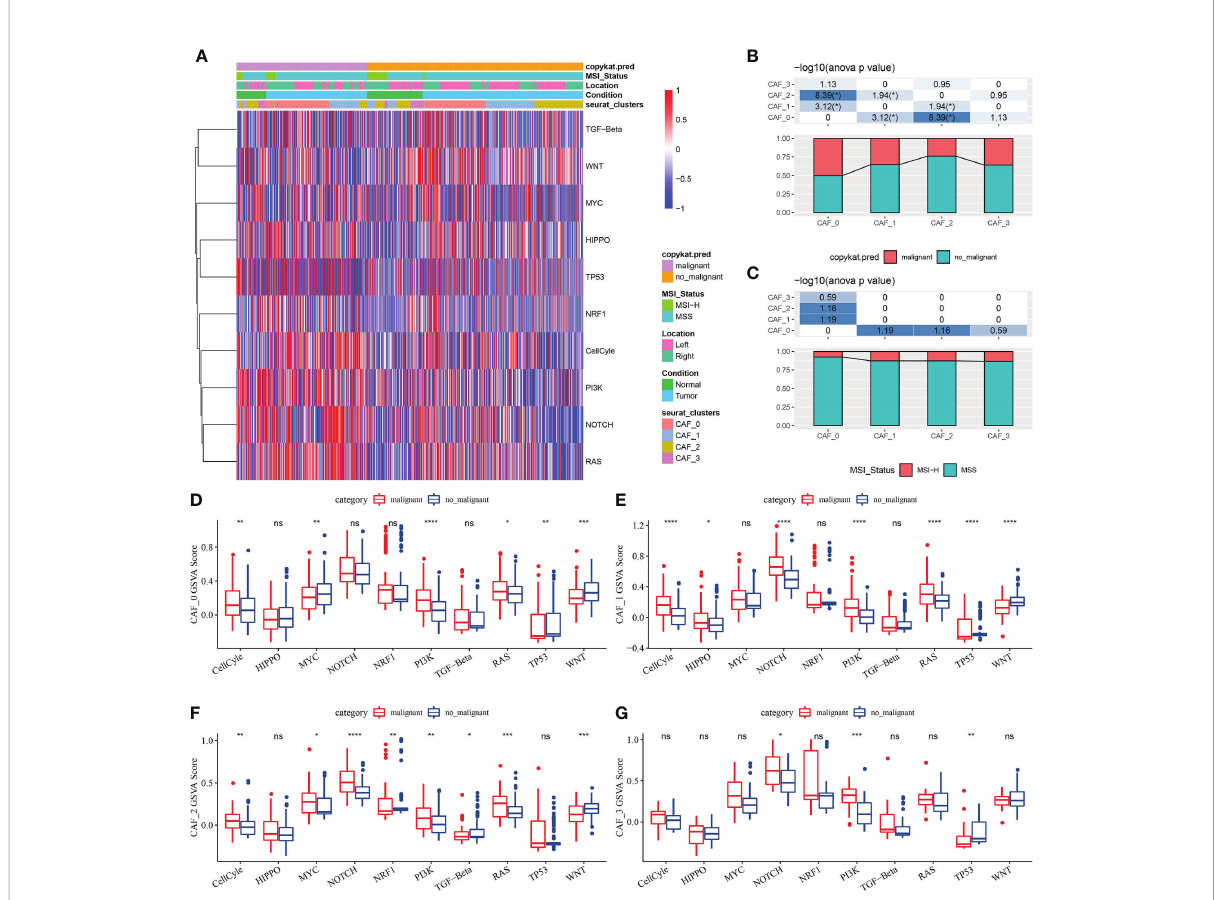
FIGURE 2 (A) Heat map of the scores of 10 tumour-related pathways enriched in CAFs; (B) Comparison of CAF subpopulations in malignant and non- malignant cells; (C) Comparison of CAF subpopulations in terms of MSI status; (D) Comparison of the scores of 10 tumour-related pathways between malignant and non-malignant cells in the CAF_0 subgroup; (E) Comparison of the scores of 10 tumour-related pathways between malignant and non-malignant cells in the CAF_1 subgroup; (F) Comparison of the scores of 10 tumour-related pathways between malignant and non-malignant cells in the CAF_2 subgroup; (G) Comparison of the scores of 10 tumour-related pathways between malignant and non- malignant cells in the CAF_3 subgroup; (Wilcoxon test; *P < 0.05; **P < 0.01; ***P < 0.001; ****P < 0.0001). ns, no signi fi